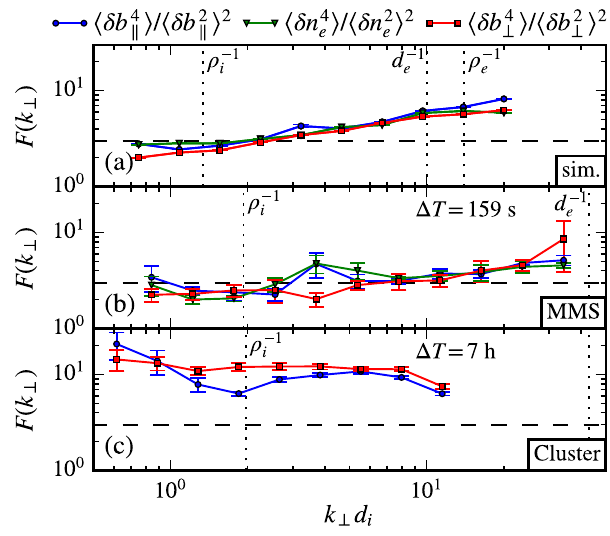
FIG. 3. Scale-dependent flatness results obtained from the simulation (a), MMS interval (b), and the Cluster interval (c). Vertical dotted lines mark the plasma kinetic scales and the horizontal dashed lines mark the Gaussian value of